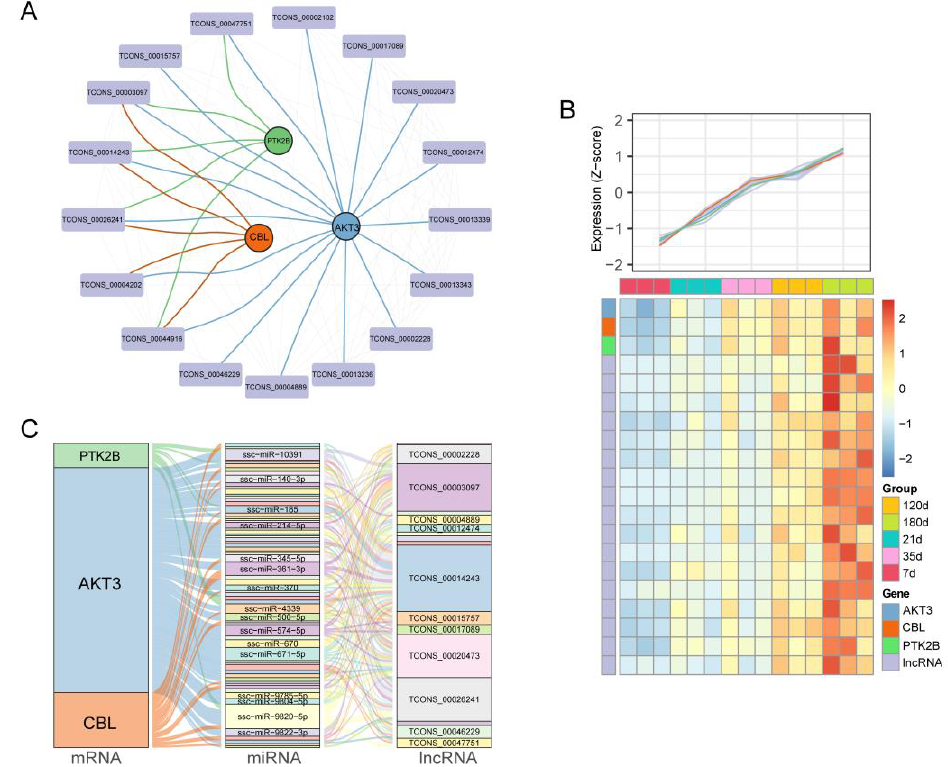
Figure 5. Co-expression network and ceRNA regulation mechanism. ( A ) Co-expression mRNA- lncRNA network of ATK3 (blue), PTK2B (green) and CBL (orange) with its co-expression lncRNAs (purple) in black module. The circular nodes represent the mRNAs, square nodes represent lncRNAs. ( B ) Heatmap showing the trend of gene expression in the co-expression network. ( C ) Sankey plot for the ceRNA network predicted by the co-expression network. The size of each rectangle, which stands for a gene, displays the degree to which that gene is connected to others.